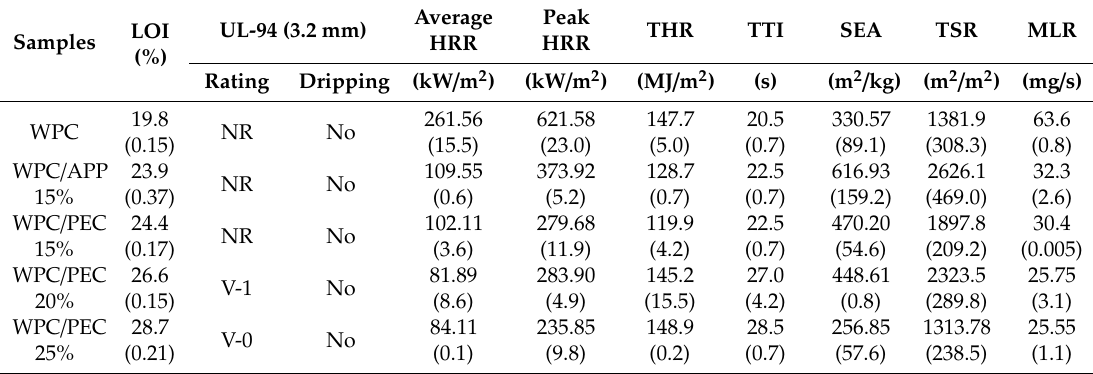
total smoke release, MLR: mass loss rate.